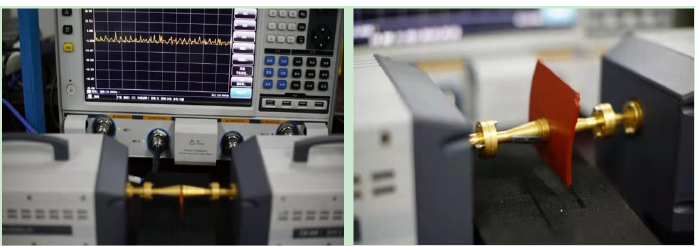
Figure 16. Experimental diagram of terahertz input return loss measurement.